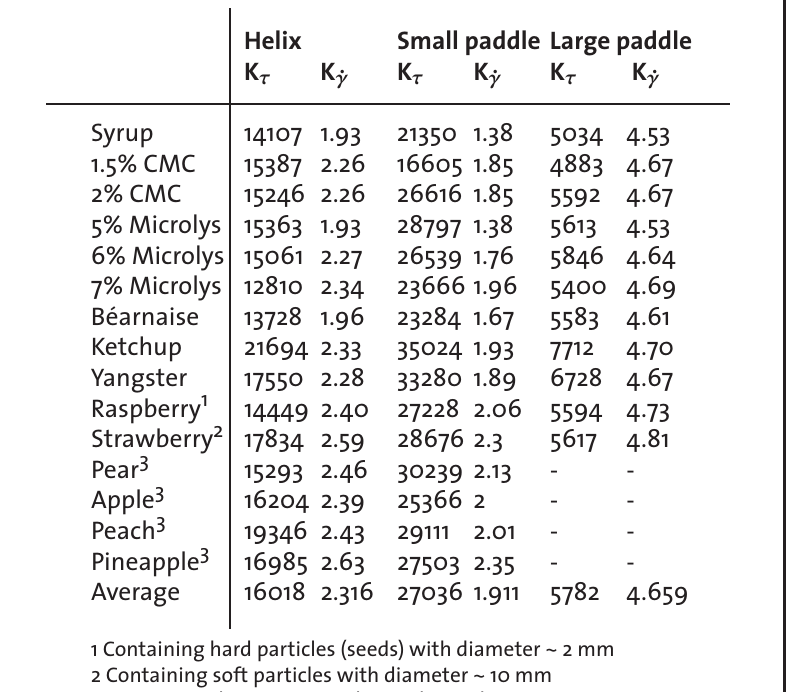
Table 1: Resulting constants, K g · and K t , for evaluated mixer sys- tems. The constants have been calculated using Eq. 5 and Eq.